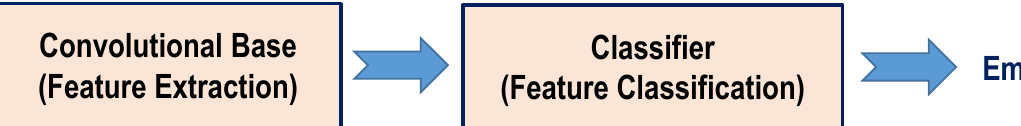
Figure 2. General architecture of transfer learning-based deep CNN model for emotion recognition.